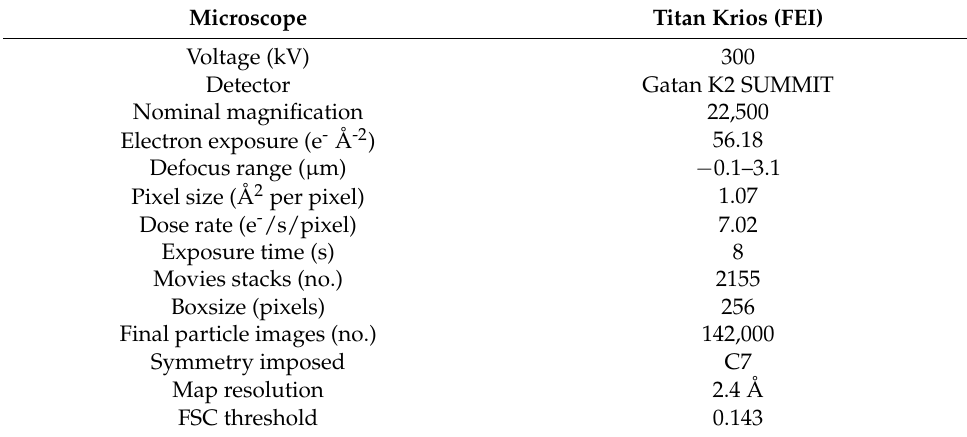
Figure 1. Purification and analysis of YnaI single particles. ( a ) SMA 2000 inactive form (styrene-maleic anhydride copolymer) and active form (styrene-maleic acid copolymer) ( b ) Size exclusion column purification profile of YnaI. ( c ) SDS-polyacrylamide gel electrophoresis (SDS-PAGE) analysis of YnaI. Lane M shows the protein marker (Bio-Rad prestained protein). YnaI is ~38 kDa (monomer) and ~265 kDa (heptamer). Lane 1–3: fractions of the second SEC peak. ( d ) Representative raw micrograph images showing negative-stain particles of YnaI. ( e ) Representative micrograph of YnaI on a cryo-EM thin carbon grid. ( f ) Representative 2D classes with side, top, and high angle views. Table 1. Cryo-EM data collection and processing.